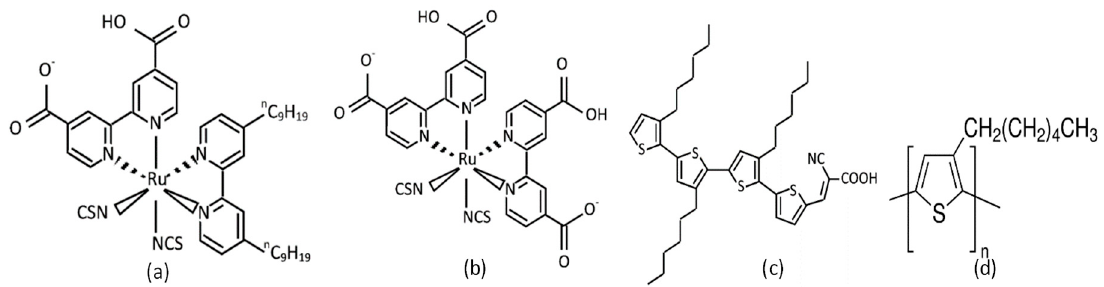
Figure 1. Chemical structure of dyes and polymer used: ( a ). Z907 [8], ( b ). N719 [8], ( c ). 4T [8,16], and ( d ) P3HT. 95